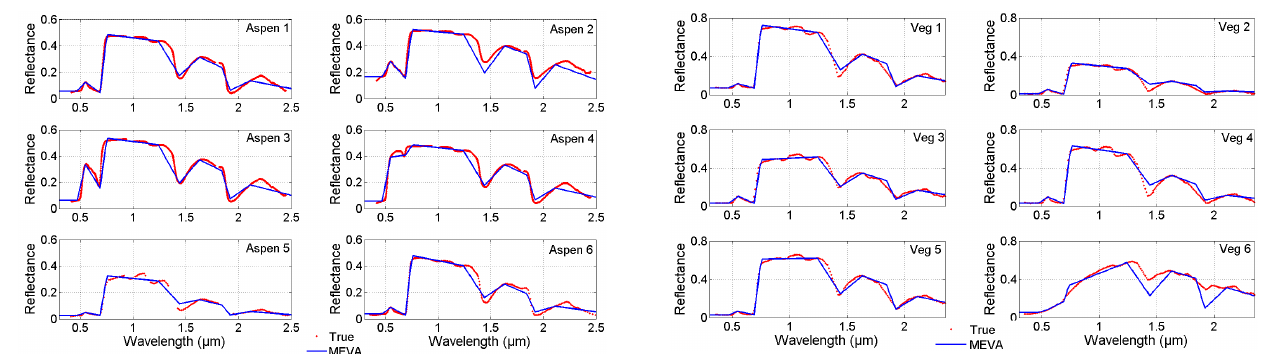
Fig. 8. In each subplot, the x-axis represents wavelength from 0.3 to 2.5µm; the y-axis represents reflectance. The dotted red curves rep- resent reflectance spectra for aspens from the USGS digital spectral library; the solid blue lines represent the MEVA results.